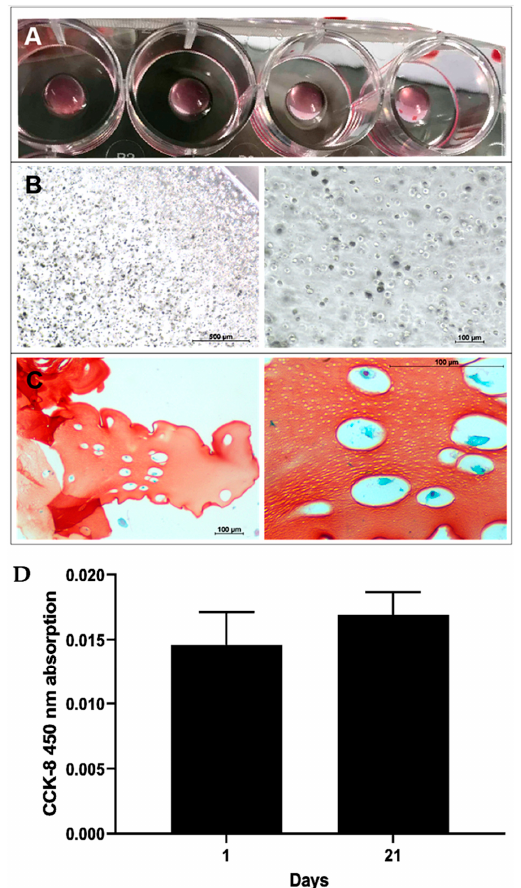
Figure 2. The generation and investigation of the CS-Tyr/Gel/BM-MSCs composite. ( A ) The micro- graph of the polymerized CS-Tyr/Gel/BM-MSCs composite. ( B ) The light microscope micrographs